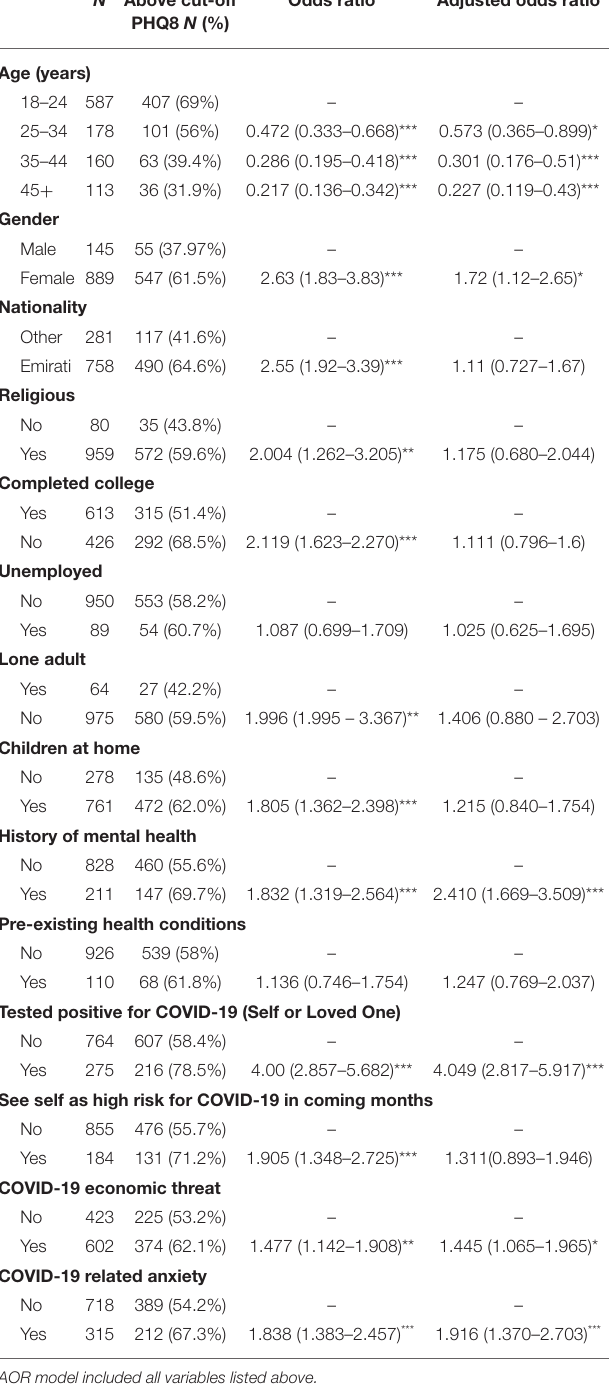
TABLE 5 | Bivariate (OR) and multivariate (AOR) logistic regression predicting PHQ8 depressive symptom scores above cut-off. N Above cut-off PHQ8 N (%)